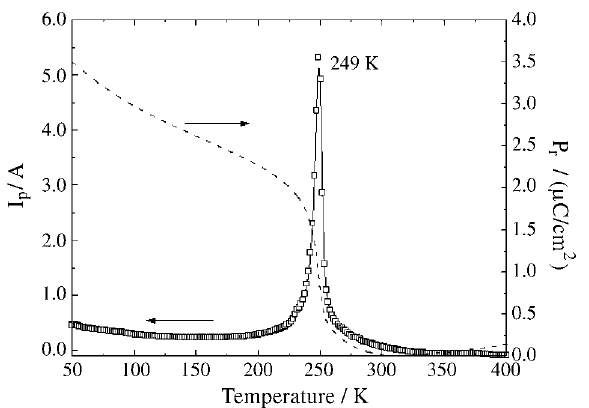
Figure 5. Pyroelectric current (I p ) and remanent polarization (P r ) for the PLZT 10/65/35 hot-pressed